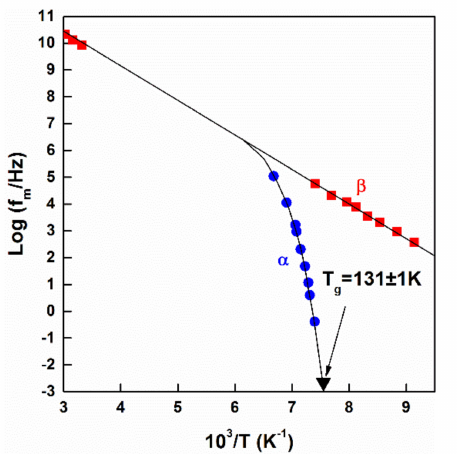
Figure 3. Temperature dependence of the peak of the dielectric relaxation frequency of a glass-forming mixture of chlorobenzene / cis-decalin. The α –process exhibits a non-Arrhenius temperature dependence and vanishes at T g . Adopted from [39], with permission from AIP Publishing LLC,